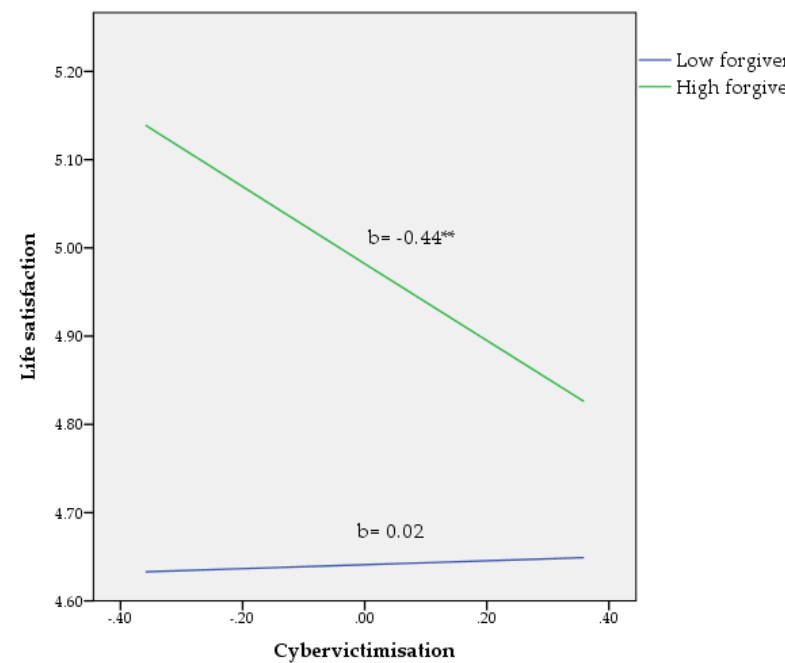
Figure 2. Relationship of traditional victimisation and forgiveness for predicting life satisfaction. *** p < 0.001. Note: values for forgiveness (moderator) are the mean and plus/minus one standard deviation ( SD ) from the mean.